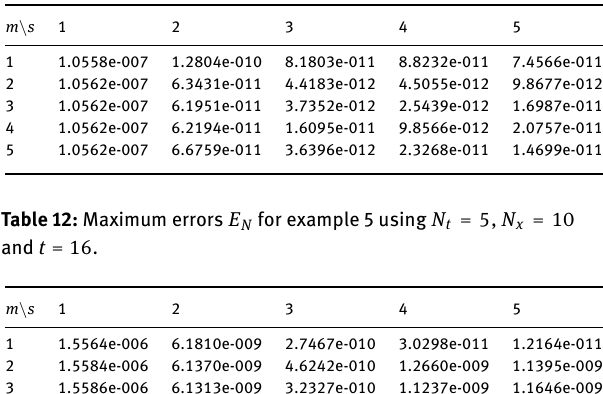
Table 11: Maximum errors E N for example 3 using N t = N x = 10 and t = 1.